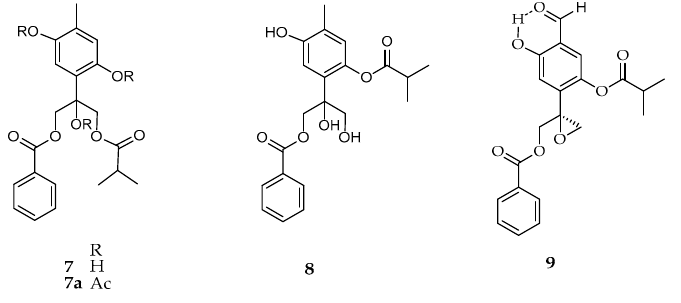
Figure 4. Chemical structures of 7 – 9 .